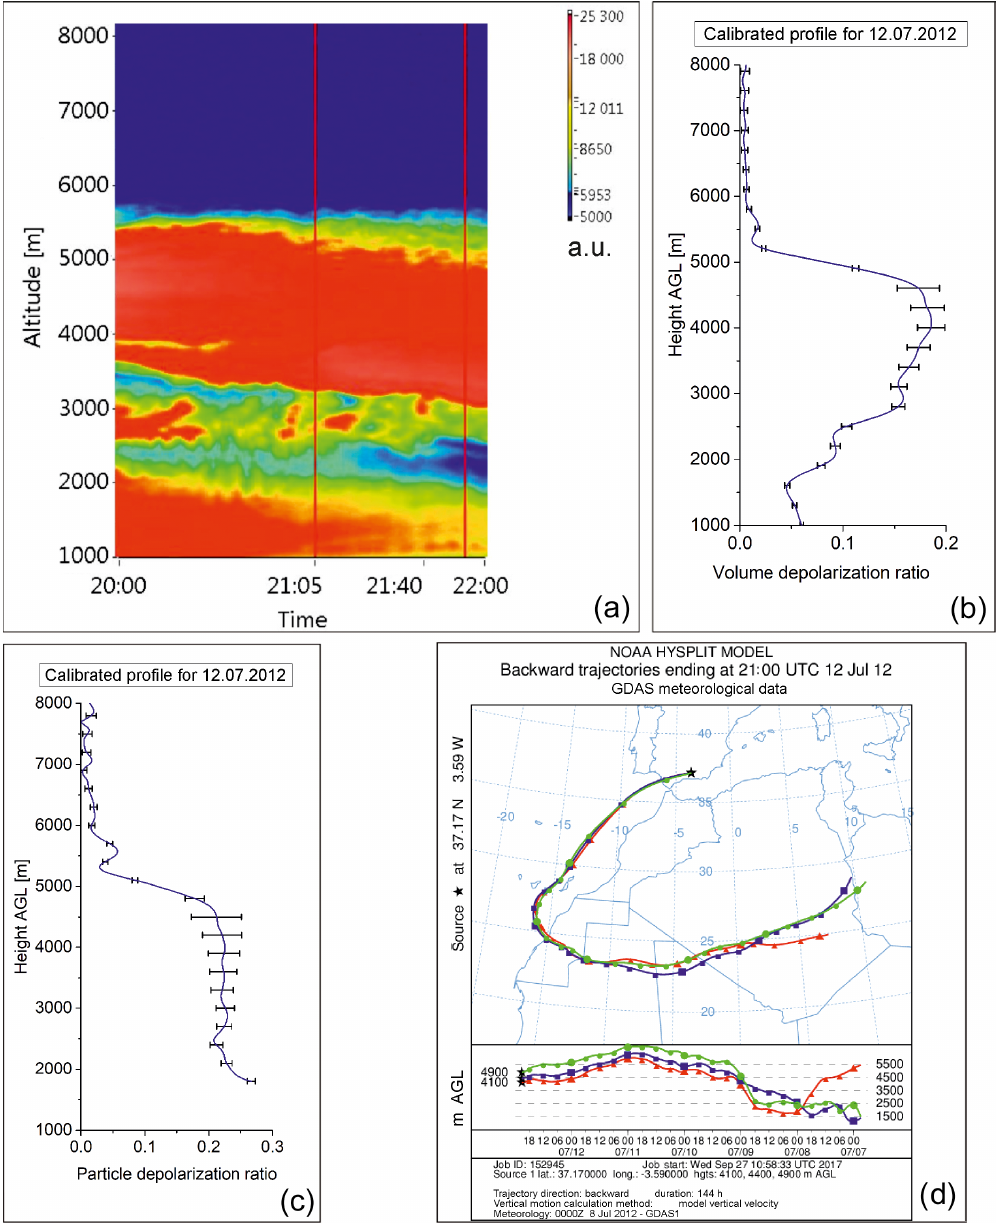
Figure 9. Data from 12 July 2012, at the Mulhacen–Granada lidar system (a) range-corrected time series at 532nm; (b) volume linear depo- larization ratio is a corrected profile at 532nm with smoothed data, 45 minutes time average and 45m vertical smoothing; (c) particle linear depolarization ratio is a corrected profile at 532nm with smoothed data, 45min time average and 45m vertical smoothing; (d) HYSPLIT back-trajectory analysis ( − 144h) for the detected layers at the Granada